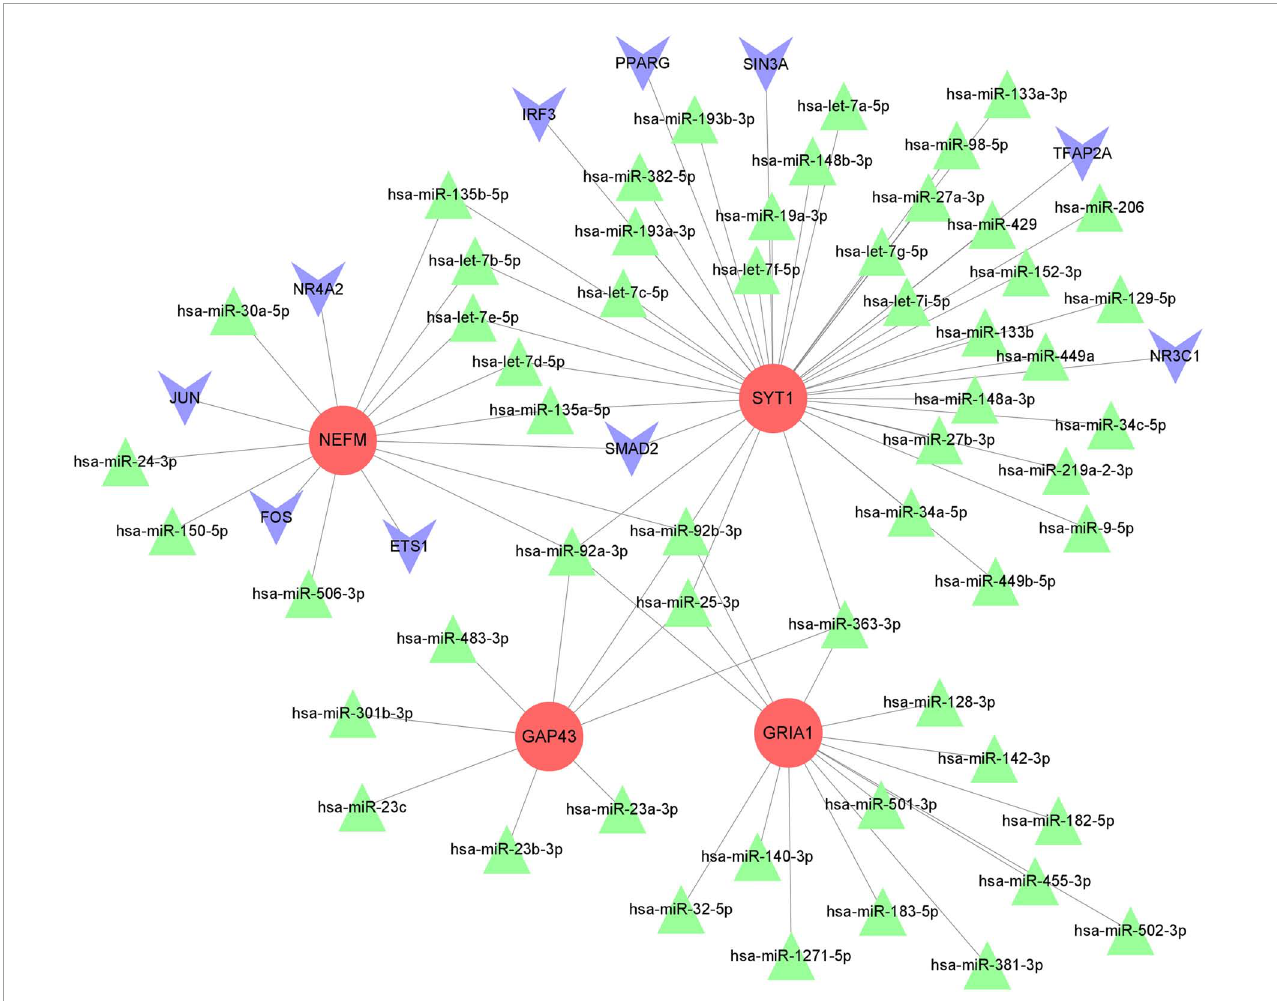
FIGURE11 The miRNA-TF-mRNA interaction network. The red circles represent marker hub genes, the blue triangles represent miRNAs, and the green inverted cones indicate TFs. mRNAs, messenger RNAs; miRNAs, microRNAs; TFs, transcription factors.